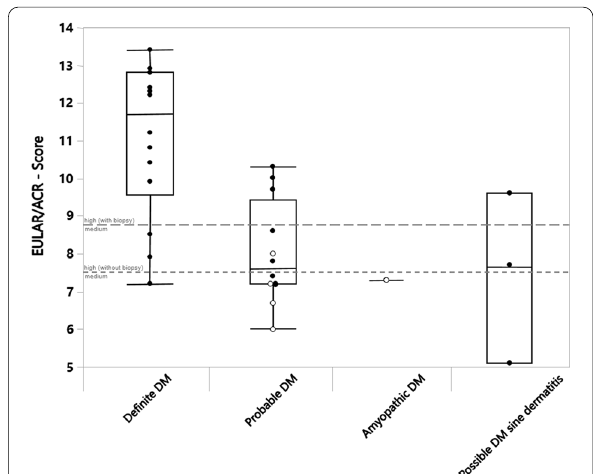
Fig. 3 Boxplot diagram of the various DM-ENMC subtypes (2003) and their EULAR/ACR score calculated using the Kruskal–Wallis test. Cases with muscle biopsy are indicated by closed circles and cases without muscle biopsy by open